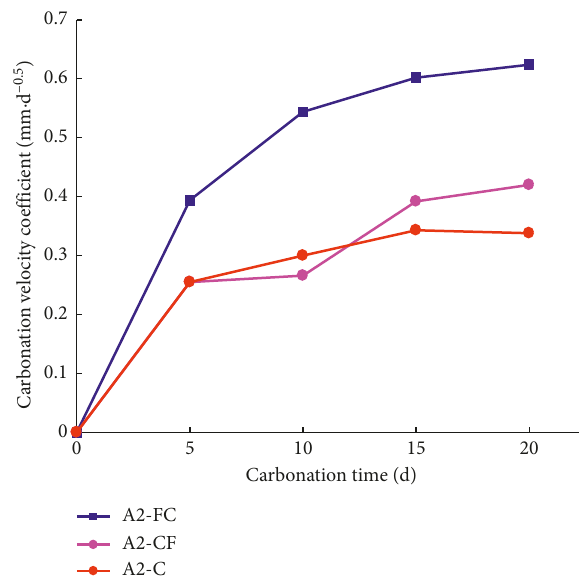
Figure 11: Carbonation velocity coefficient of A2 in different testing modes.